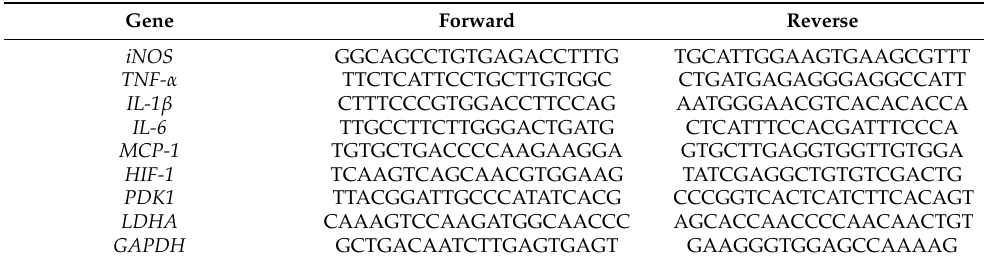
Table 1. List of real-time PCR